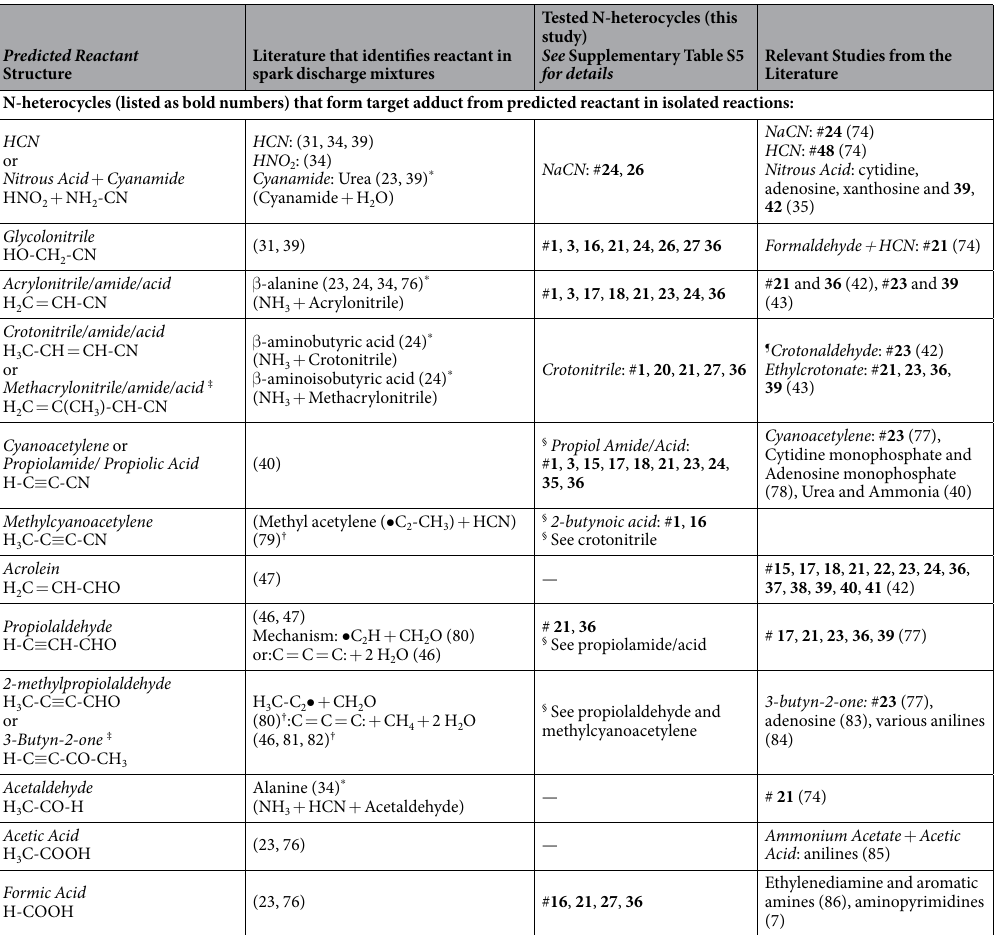
Table 1. Organics predicted to have reacted with N-heterocycles incubated in spark discharge mixtures. References 7, 23, 31, 34, 35, 39, 40, 42, 43, 46, 47, 74–86 are listed in parenthesis. N-heterocycles are listed as bold numbers following # (refer to Fig. 2 and Supplementary Table S1 for structures and names, respectively). * or † Indicates that the reactant was not directly detected, but that its formation in spark mixtures is inferred based on the identification of: * The product of the predicted reactant with other spark compounds (mechanism shown in parenthesis) or † Compounds that combine to form the predicted reactant. ‡ Methacrylonitrile/amide/acid and 3-butn-2-one are equally plausible for generating the observed methylated carbonyl side chain as crotonitrile/ amide/acid and 2-methylpropiolaldehyde, respectively. Note that Wolman and colleagues 24 previously detected β -aminobutyric acid (from crotonitrile) and β -aminoisobutyric acid (from methacrylonitrile) in